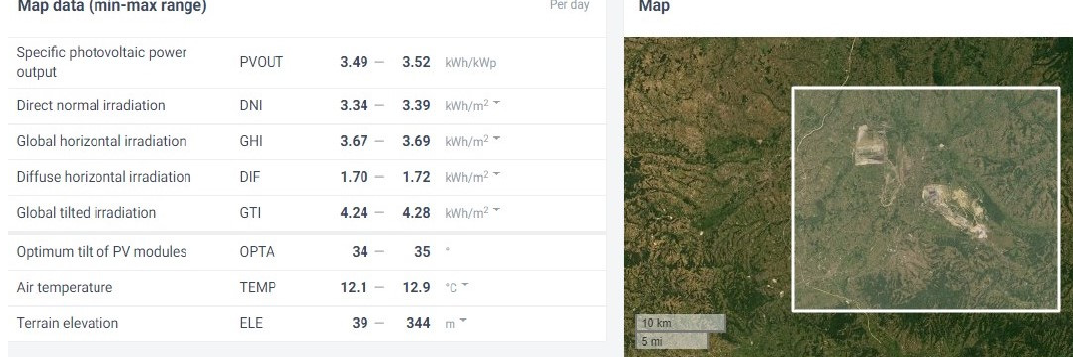
Figure 4. Coal basin Kolubara west (available flat surface 1900 ha) and east opencast mine area photovoltaic possibilities (available flat surface 1700 ha) (data obtained from the “Global Solar Atlas 2.0, a free, web-based application is developed and operated by the company Solargis s.r.o. on behalf of the World Bank Group, utilizing Solargis data, with funding provided by the Energy Sector Management Assistance Program (ESMAP). For additional information: https://globalsolaratlas.info) [9].